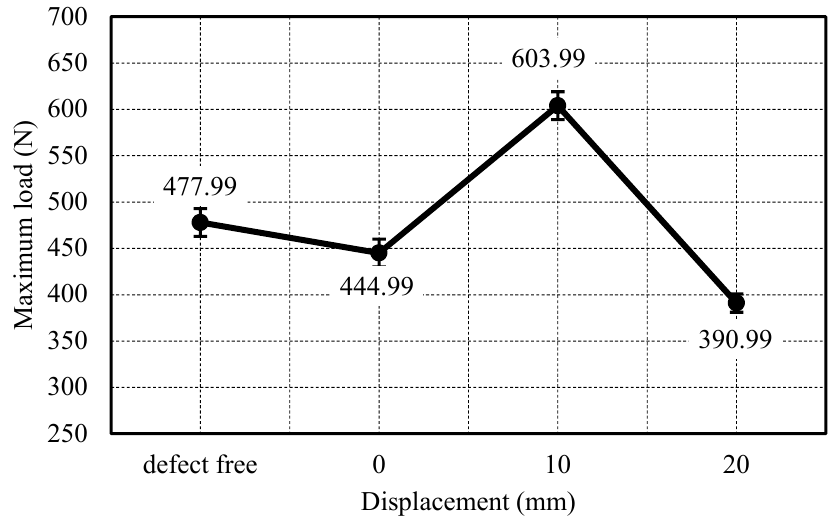
Figure 14. Effect of the defect location on the maximum load for white samples set. Figure 14. E ff ect of the defect location on the maximum load for white samples set.